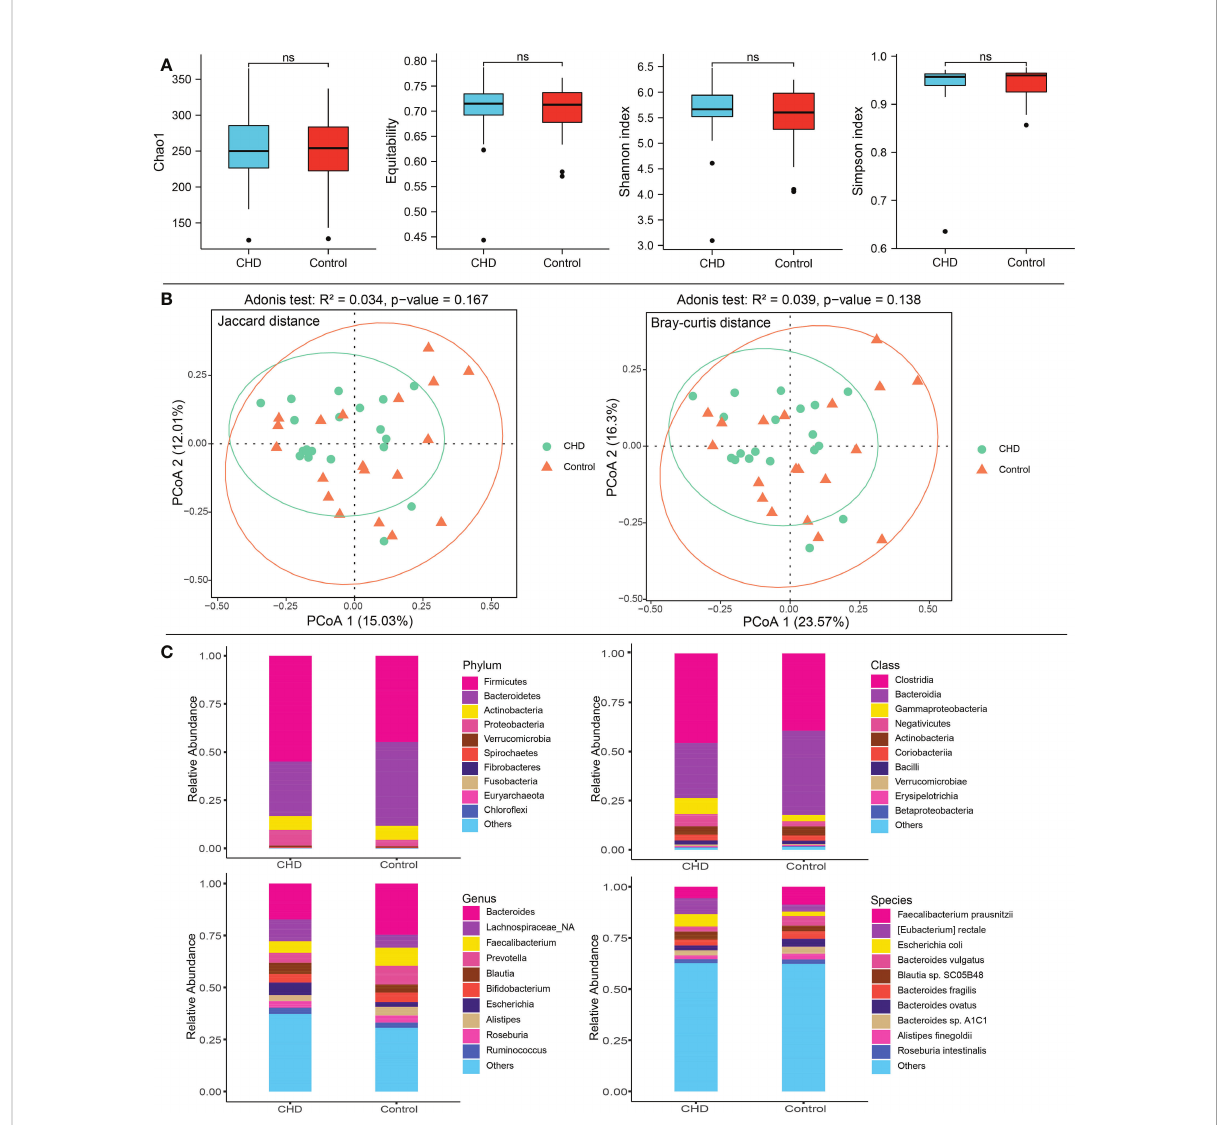
FIGURE 1 Diversity and taxonomic composition of gut microbiota in CHD and control groups. (A) a -diversity including Chao1, equitability, shannon and simpson index. (B) b -diversity and PCoA based on Jaccard and Bray-Curtis distance metrics. (C) Taxonomic composition of gut microbiota at phylum, class, genus, and species levels between CHD and control groups. ns, no signi fi